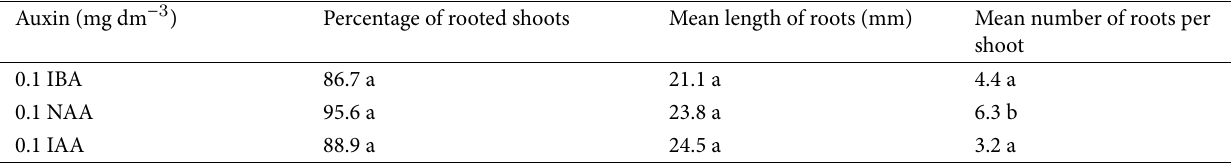
Table 4 Rooting of Primula farinosa shoots on MS medium supplemented with various auxins after 5 weeks of rooting. − 3 Auxin (mg dm